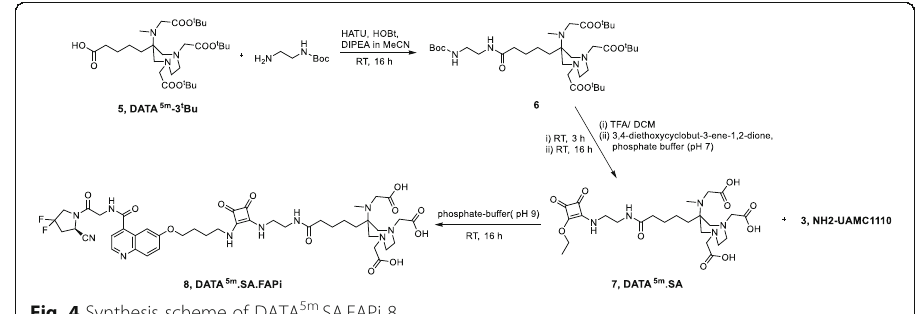
Fig. 4 Synthesis scheme of DATA 5m .SA.FAPi 8